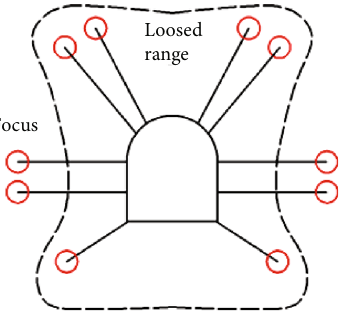
Figure 14: The roadway support misunderstanding under a high spherical